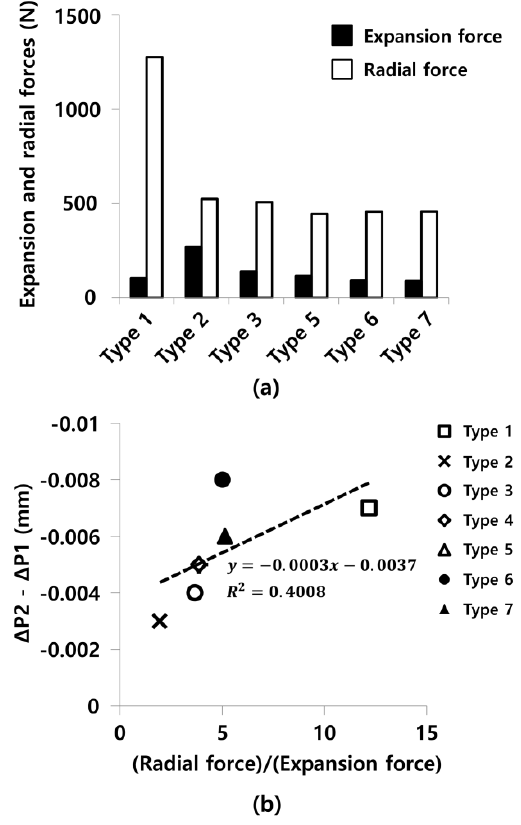
Figure 10. ( a ) Expansion and radial forces from Types 1–7 except Type 4, where the tube’s inner groove does not contact the expansion ball; and ( b ) correlation between the deformation of the tube’s inner grooves and the radial force divided by the expansion force.